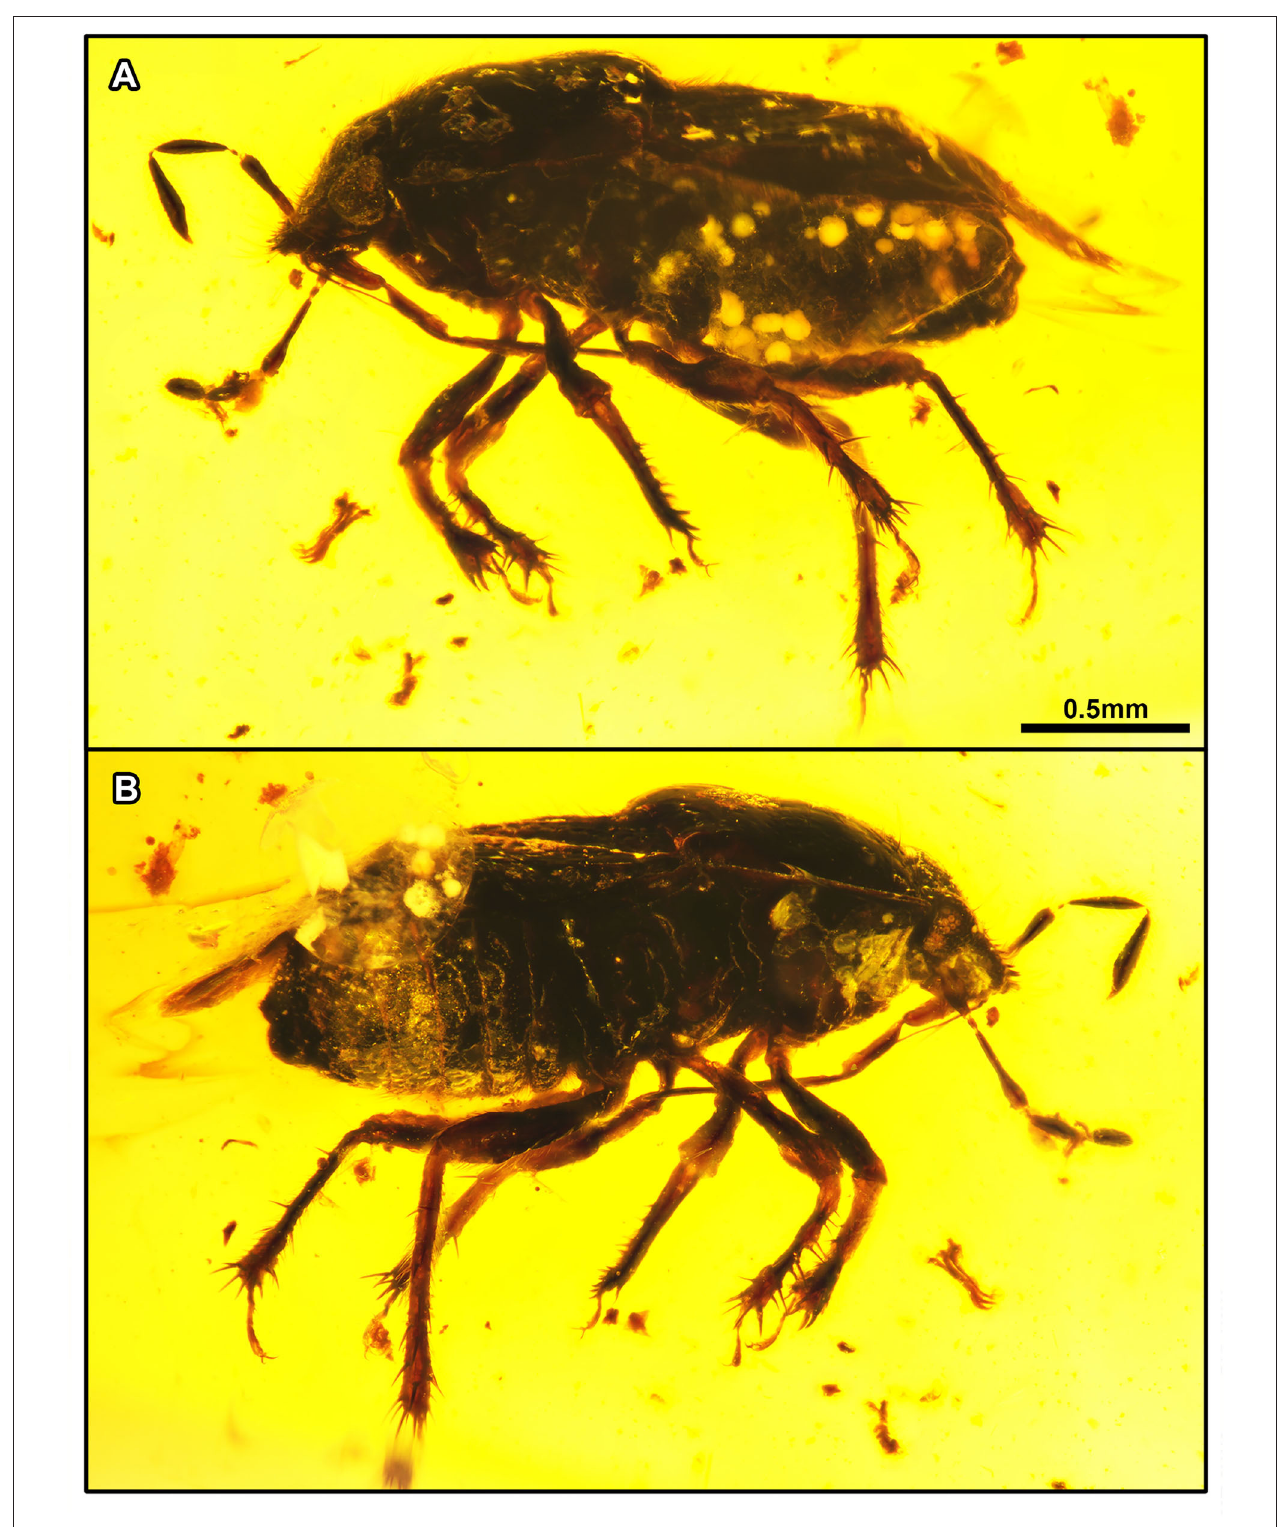
FIGURE 4 | Acanthamnestus ovoideus gen. et sp. nov., in Burmese amber. Holotype, CNU-HET-MA2019003 (female). (A) Habitus in left lateral view. (B) Habitus in right lateral view. Scale bars: A = B = 0.5mm.